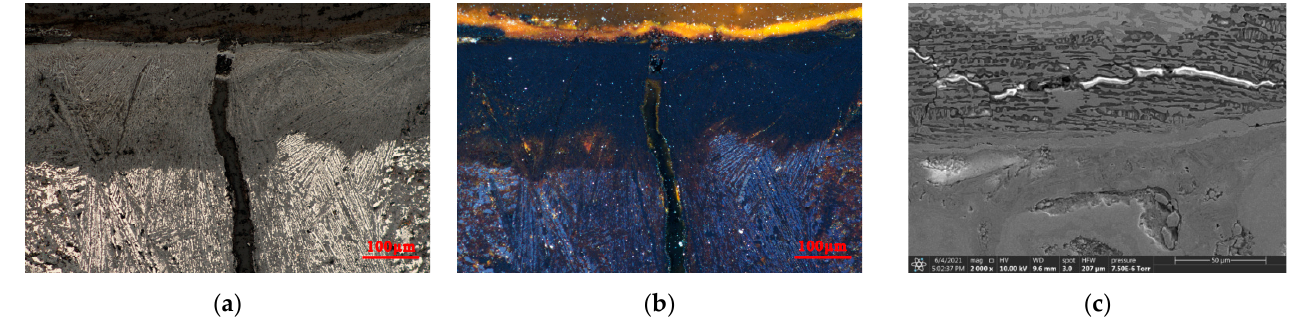
Figure 4. Corrosion delamination of the iron pot samples from the “Nanhai I” shipwreck. ( a ) Metallograph in brightfield. ( b ) Metallograph in brightfield with polariscope. ( c ) SEM of corrosion separated layer.